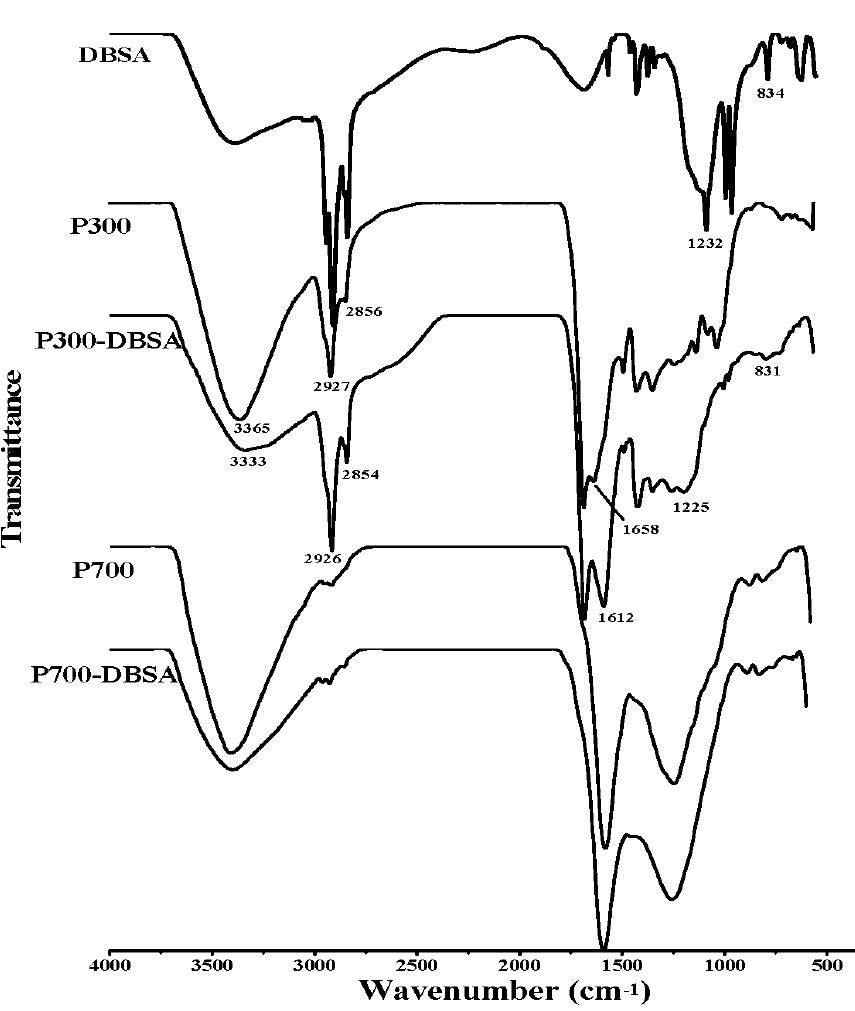
Figure 6. IR spectra of DBSA, poplar leaf biochars, and their interaction complexes.